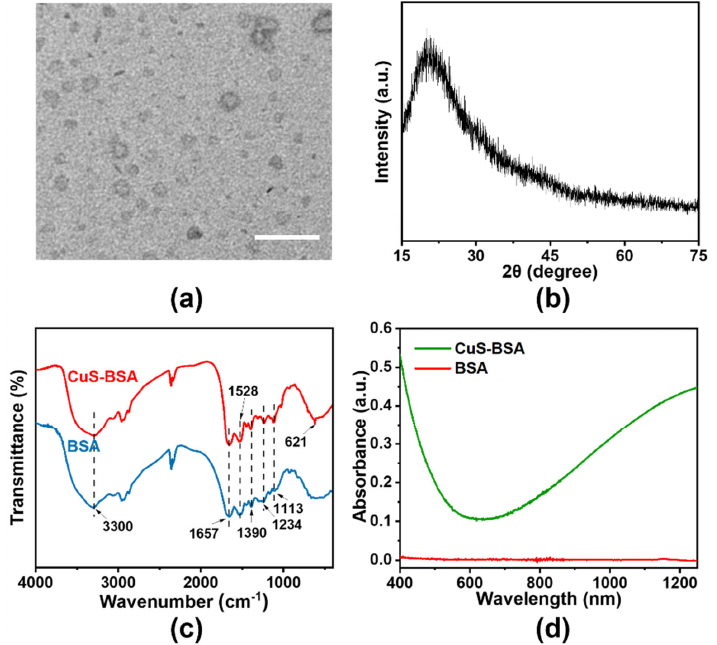
Figure 1. Characterizations of CuS − BSA. ( a ) TEM image of CuS − BSA. Scale bar: 50 nm. ( b ) XRD pattern of CuS − BSA. ( c ) FT − IR spectroscopy of CuS − BSA and BSA. ( d ) UV − Vis − NIR absorbance spectra of CuS − BSA and BSA. pattern of CuS–BSA. ( c ) FT–IR spectroscopy of CuS–BSA and BSA. ( d ) UV–Vis–NIR absorbance spectra of CuS–BSA and BSA.